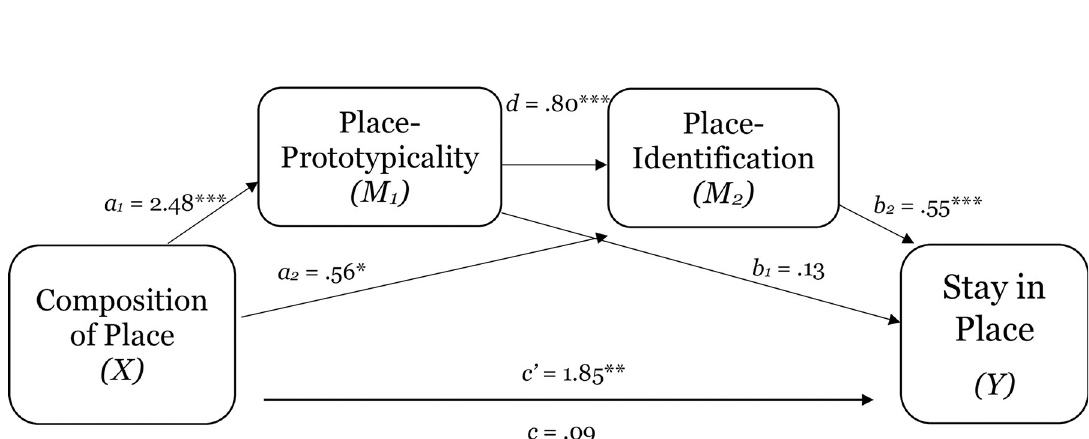
Fig 6. The serial mediating effect of place-prototypicality and place-identification in the relation between composition of place and intentions to stay in place in Study 1d. Notes: � p < .05, �� p < .01, ��� p < .001; All presented effects are unstandardized; c’ is direct effect of composition of place on comfort; c is total effect of composition of place; d is effect of place-prototypicality on place- identification (sense of belonging).